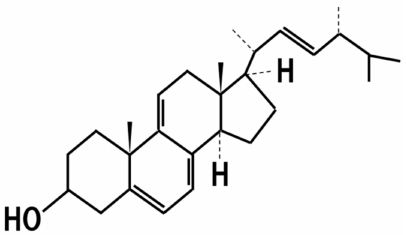
Figure 11. Chemical structure of 14-dehydroergosterol.